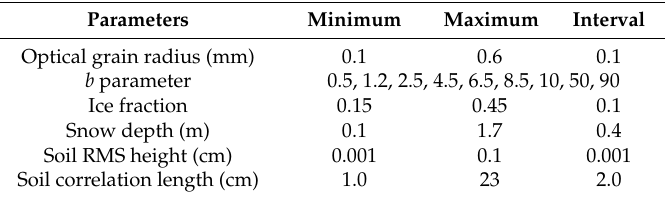
Table 1. Snow and underground parameters used to generate the database.